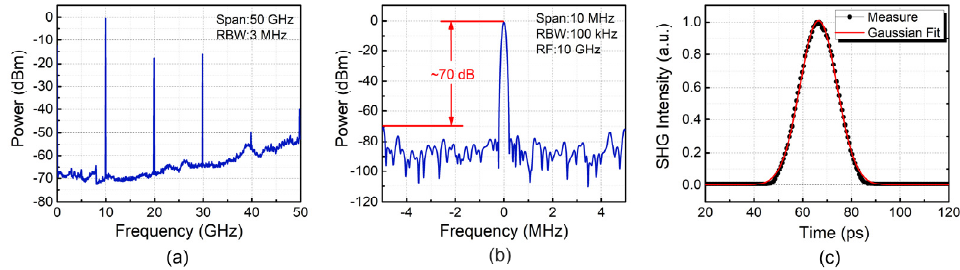
Figure 5. The 10 − gigahertz microwave signal output of the PM-YIG-RMLL ( a ) RF power spectrum in a 50 − gigahertz span; ( b ) RF power spectrum in a 10 − MHz span; ( c ) autocorrelation trace fitting.